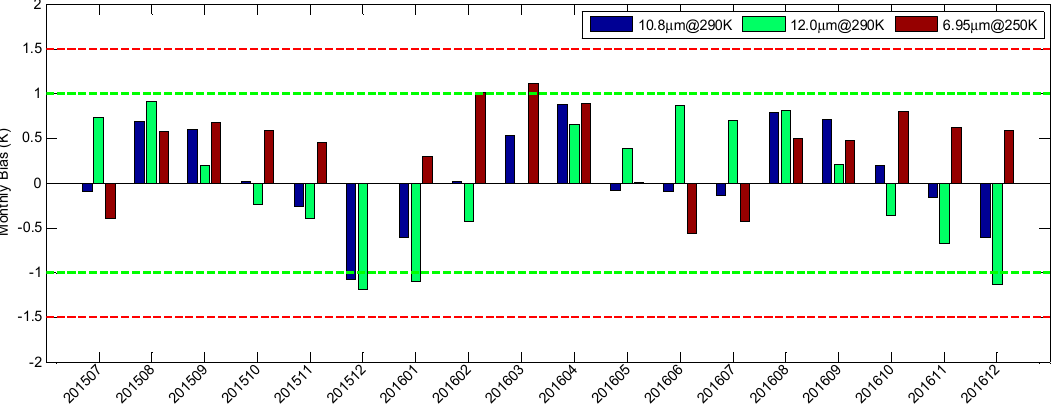
Figure 9. Monthly biases of main infrared bands of FY-2G/VISSR satellite between July 2015 and December 2016 against METOP-A/IASI.